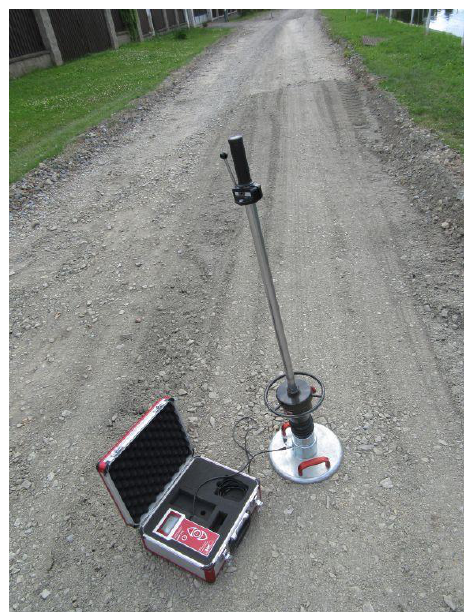
Figure 23. The equipment for the impact load test with a light dynamic plate. By ArtepGeo.